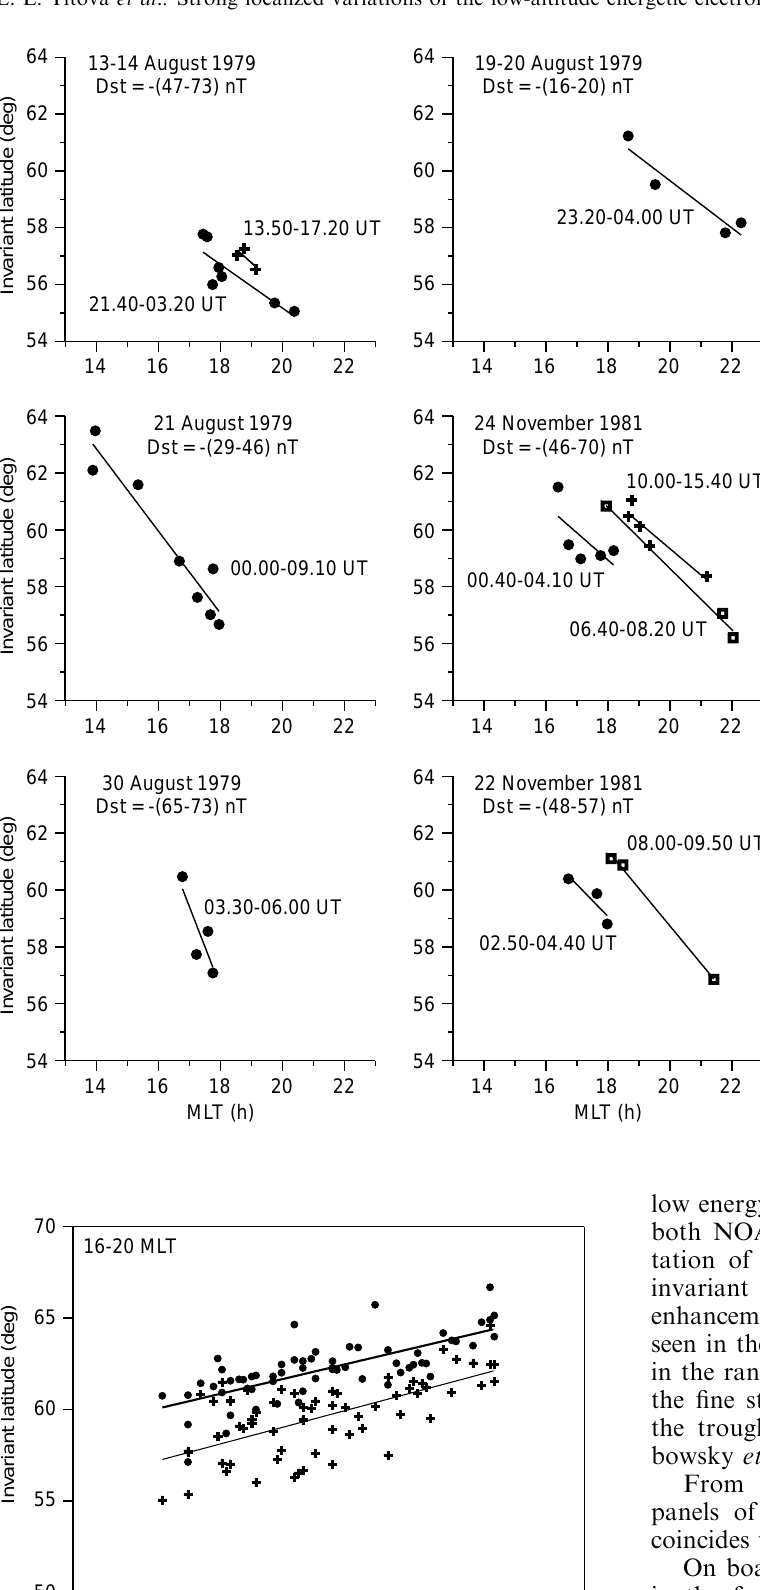
Fig. 6. Latitudes of the cli(cid:128) ( crosses ) and low-latitude edge of proton precipitation ( dots ). Linear fits showing the dependence on Dst are also presented. The data from the 16–20 MLT sector